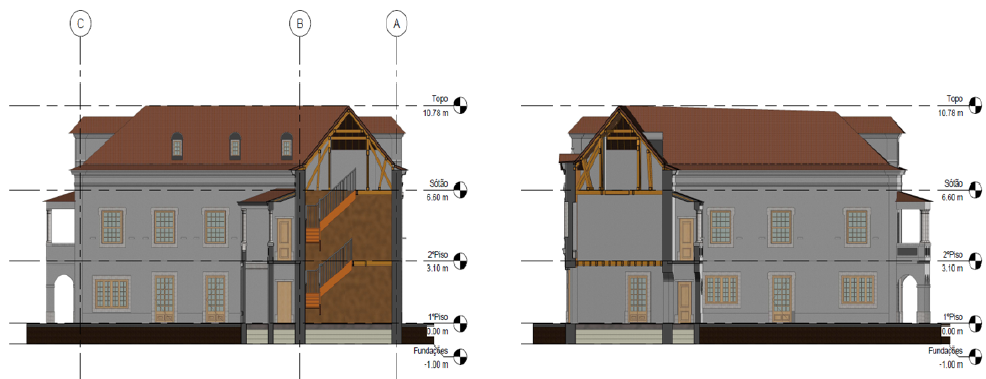
Figure 30. Details of the roof incorporated in the HBIM model.